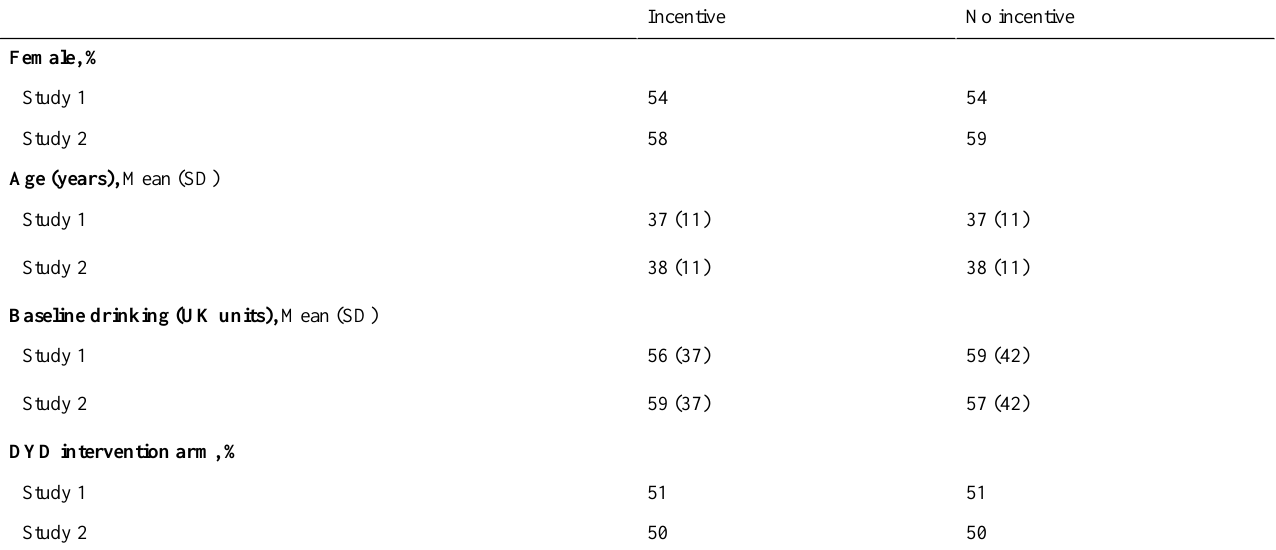
Table 1. Baseline characteristics of participants in study 1 and study